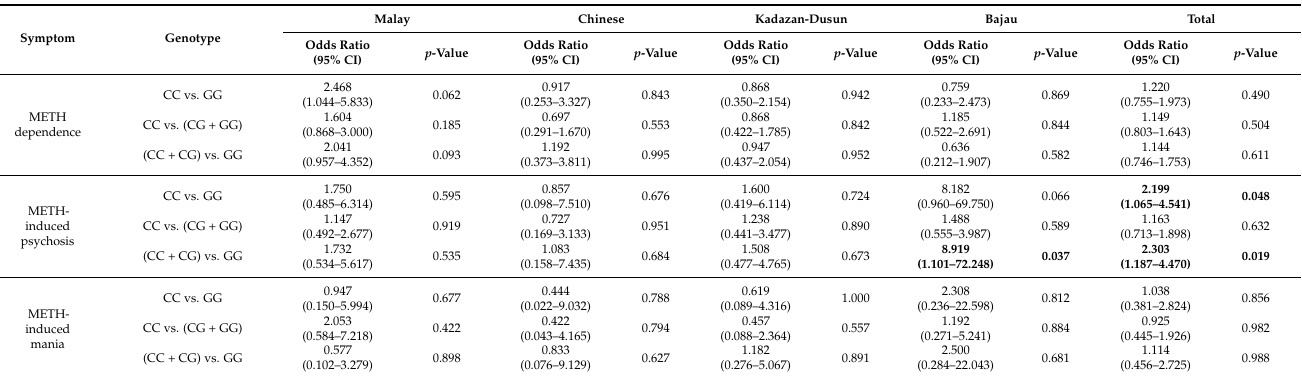
Table 4. Odds ratio in various genetic models for the different ethnic groups in METH dependence, METH-induced psychosis, and